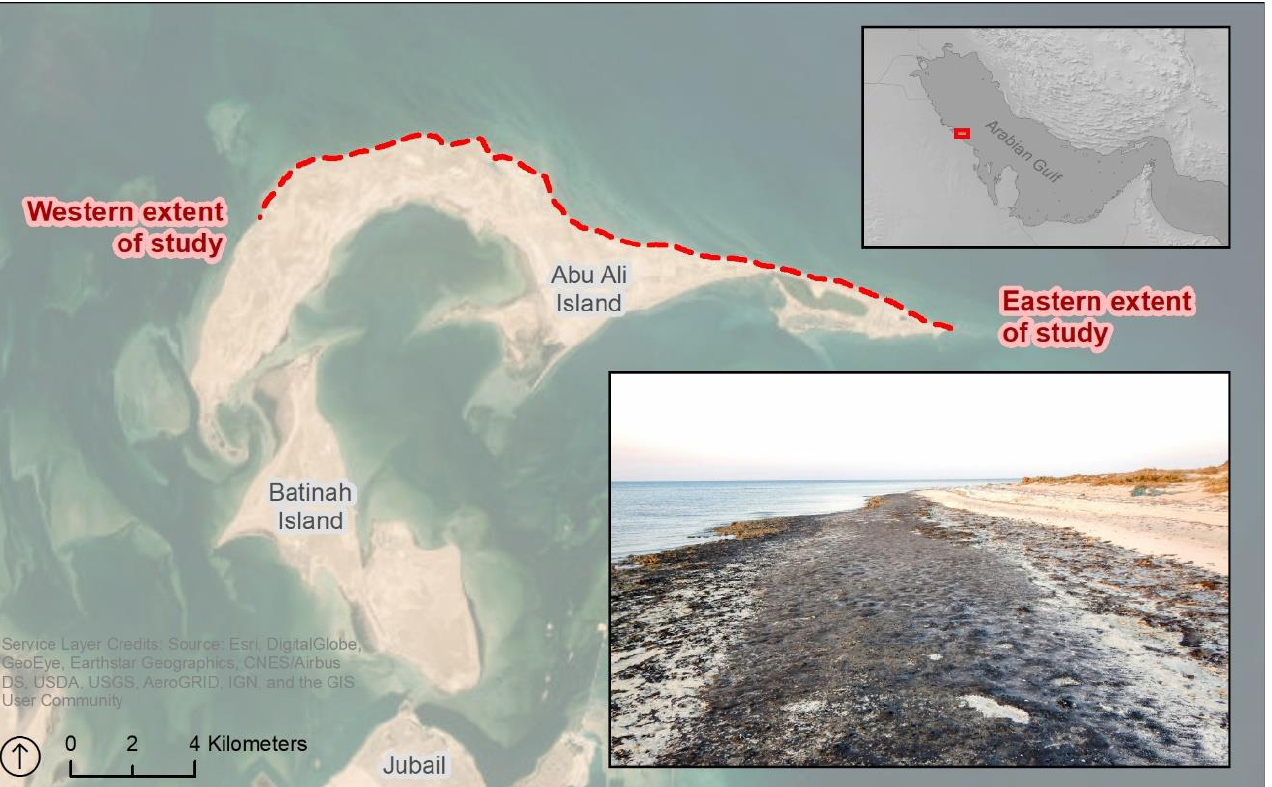
Figure 1. Study extent along Abu Ali Island north of Jubail on the Arabian Gulf coast of Saudi Arabia. Inset shows photograph of typical shoreline location with visible asphalt pavement seaward of sand beach.